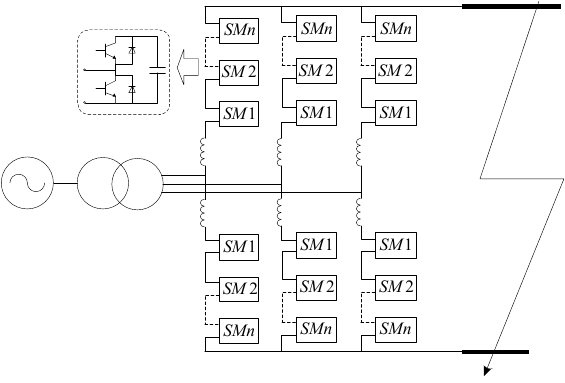
Figure 1. Schematic diagram of pole ‐ to ‐ pole faults in MMC ‐ HVDC (multi ‐ modular converter based high voltage direct current).